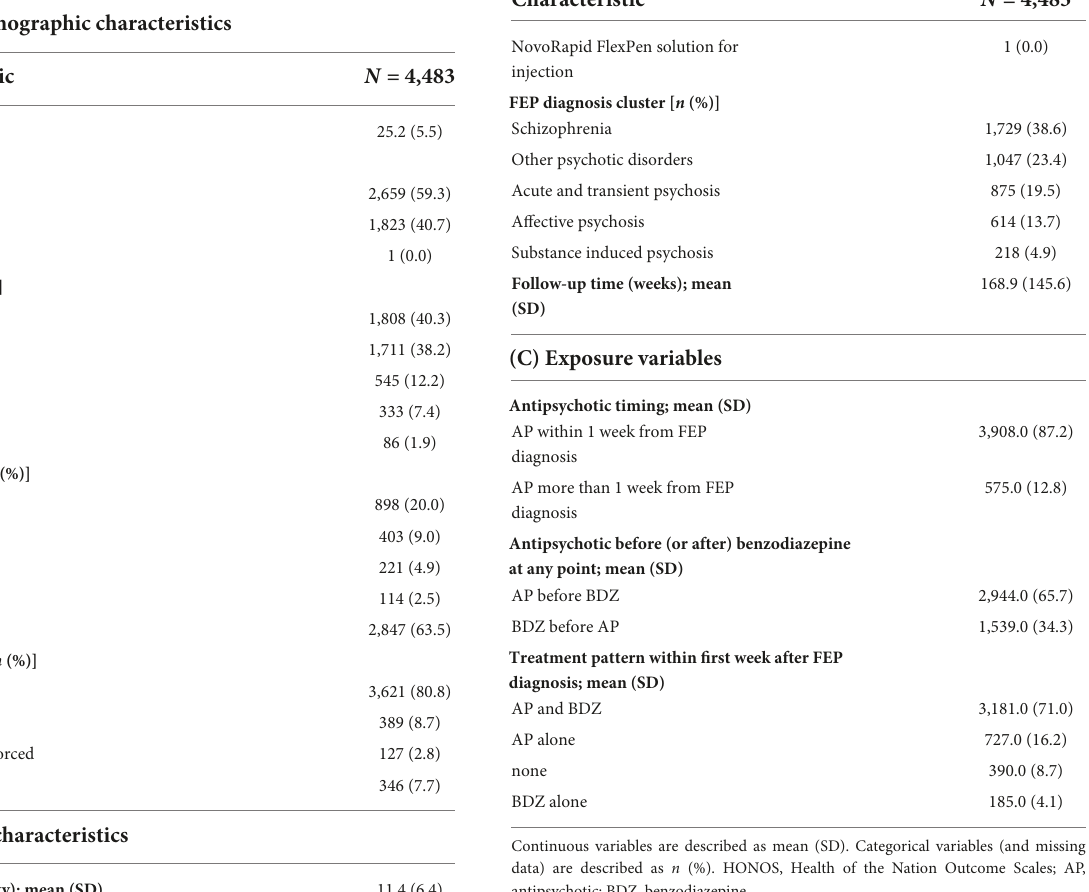
TABLE 1 Sociodemographic characteristics, clinical characteristics and exposure variables of study population ( n =